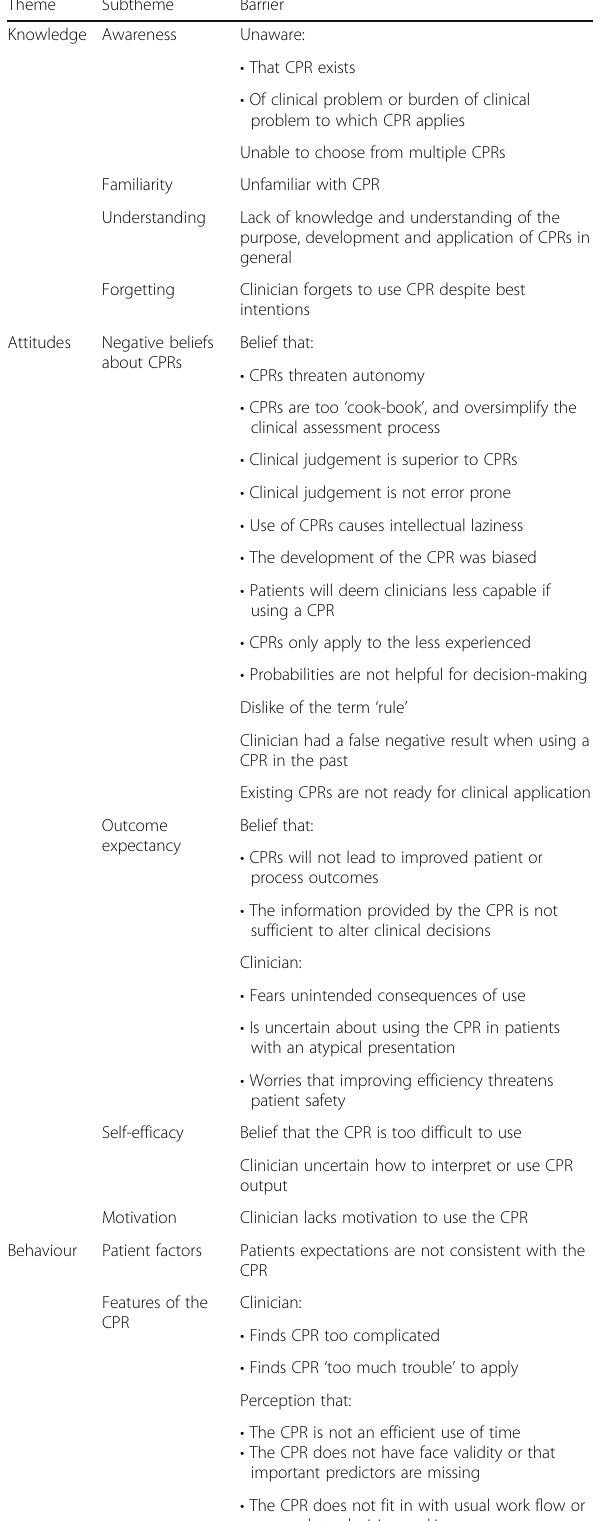
Table 4 Barriers to the use of clinical prediction rules in practice identified in the literature